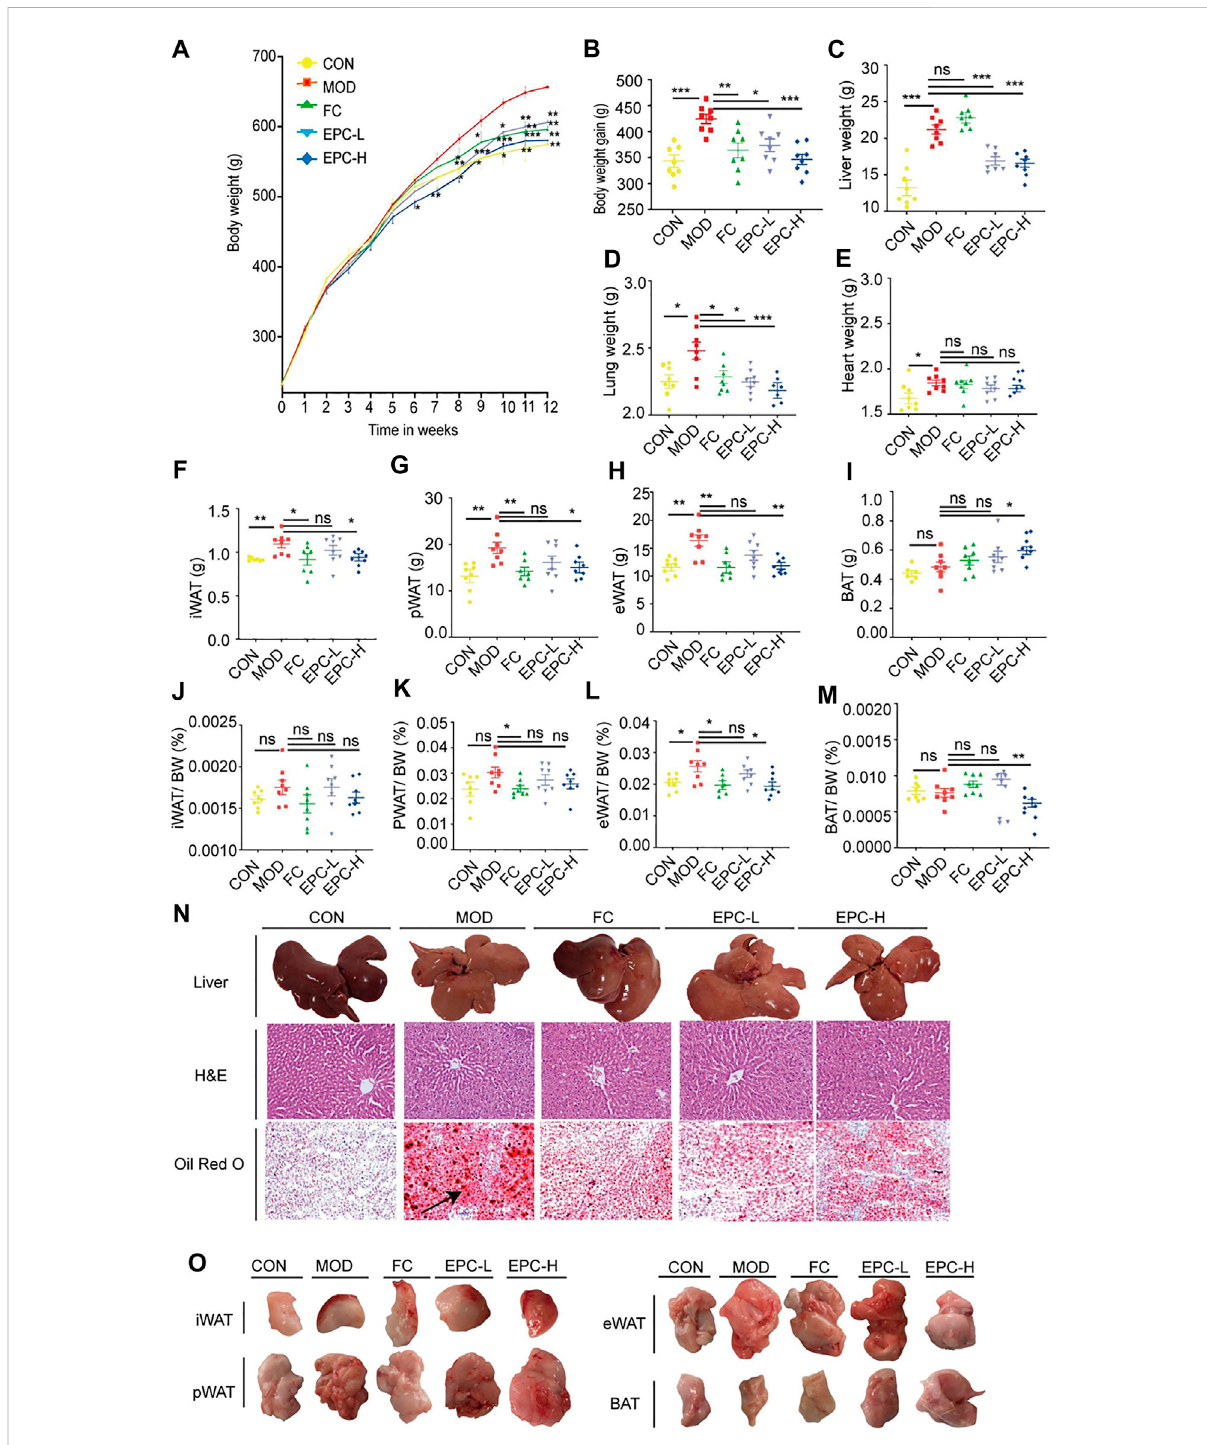
FIGURE 2 EPCamelioratedMAFLDinrats. (A) Bodyweight(BW). (B) BWgain. (C-E) Organwetweight. (F) Inguinalwhiteadiposetissue(iWAT). (G) Perirenal white adipose tissue (pWAT). (H) Epididymis white adipose tissue (eWAT). (I) Brown adipose tissue (BAT). (J) iWAT/BW ratio. (K) pWAT/BW ratio. (L) eWAT/BW ratio. (M) BAT/BW ratio. (N) Representative rat liver images of hematoxylin and eosin (H&E) and Oil Red O staining per group (X200). (O) Representative iWAT, pWAT, eWAT, BAT. (N) Brown adipose tissue (BAT). One-way analysis of variance (ANOVA) was conducted for the group comparison. n =8,dataarepresentedasmean±SEM.* p < 0.05,** p < 0.01,*** p < 0.001 vs MODgroup.EPC, P.cocos ethanolextract;CON,normal diet control group; MOD, high-fat diet group; FC, Feno fi brate capsules; EPC-L, low-dose P. cocos ethanol extract; EPC-H, high-dose P. cocos ethanol